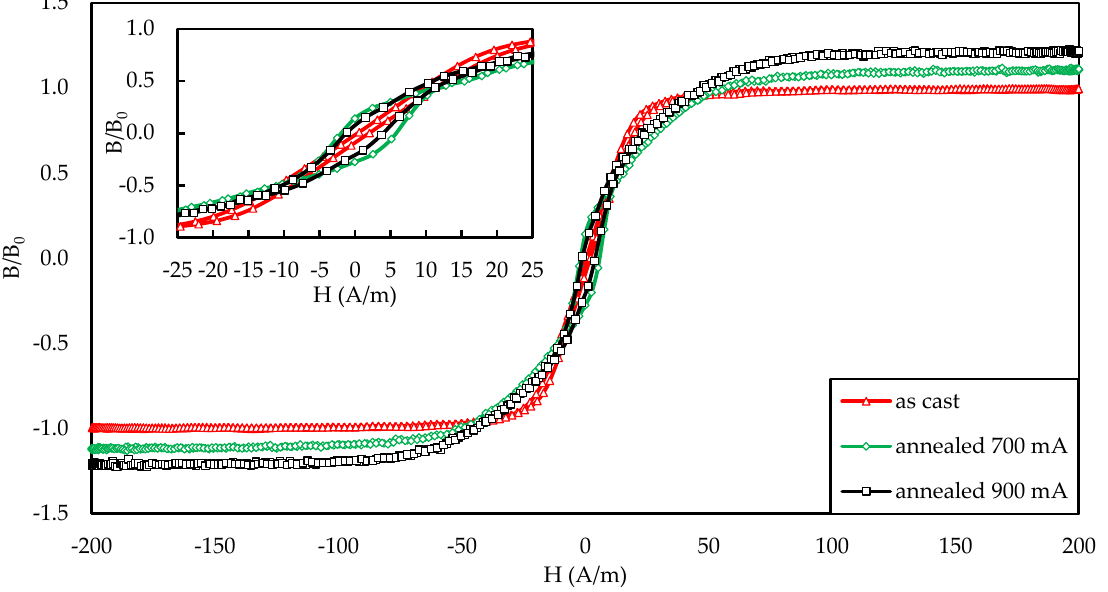
Figure 1. Hysteresis loop of as-cast and annealed samples used in the study.